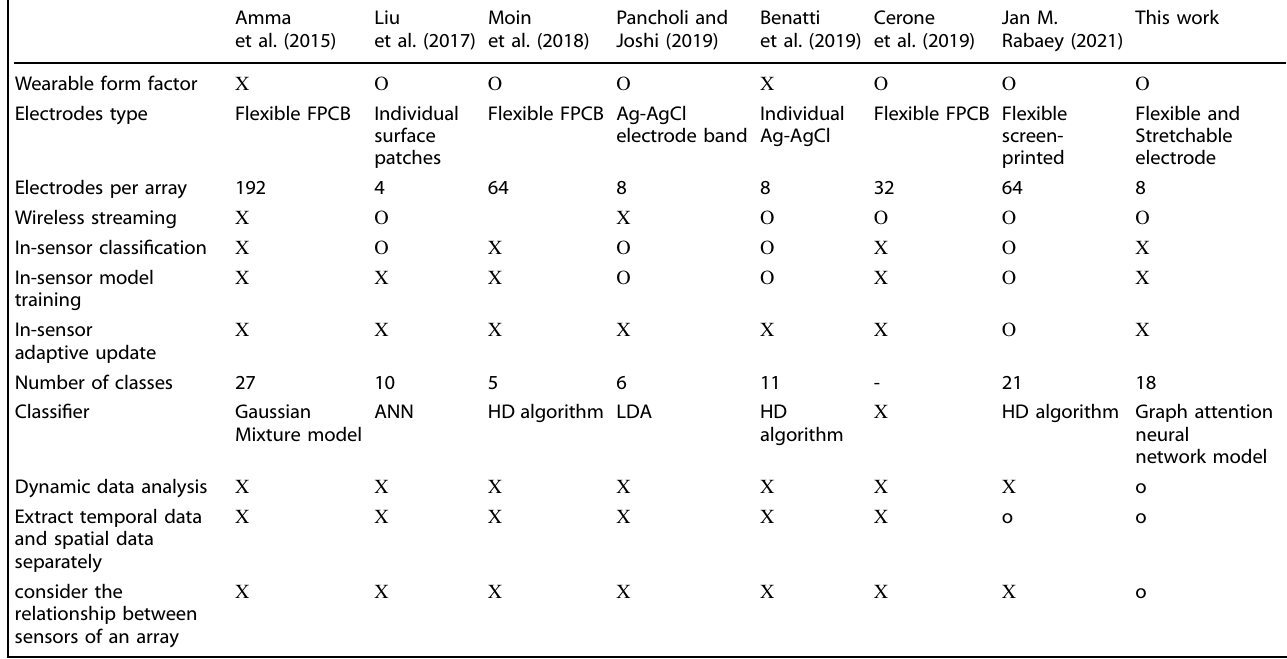
Table 1. Comparison of this work with other wearable sEMG